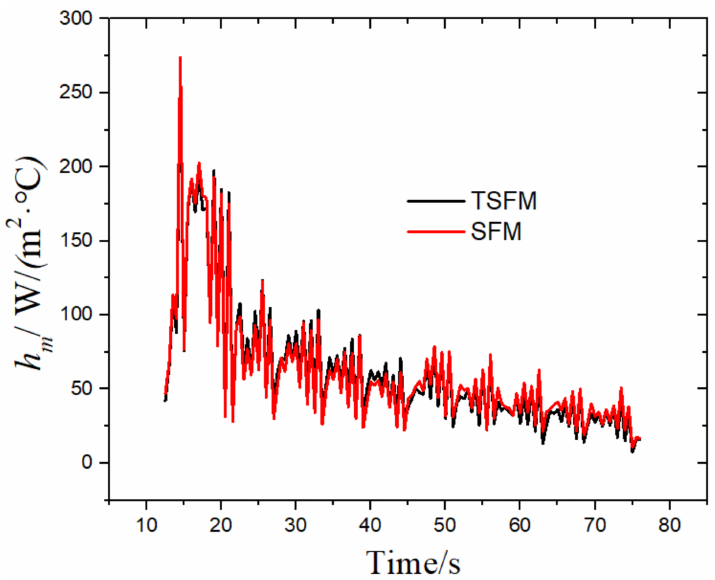
Figure 11. Comparison of the comprehensive convective heat transfer coefficients calculated by the two